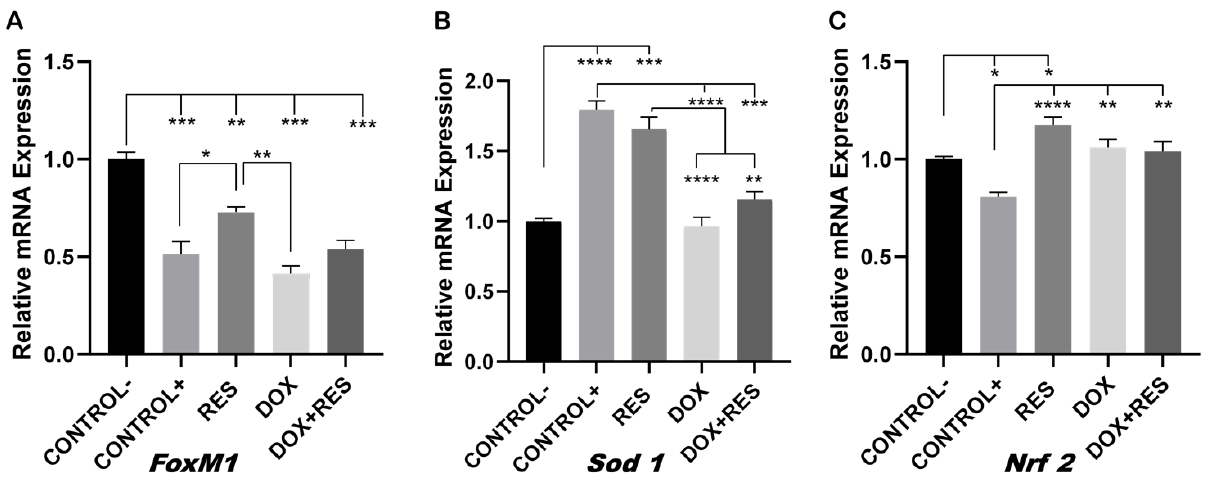
Figure 4. Involvement of FoxM1 on osteoclast differentiation and oxidative stress. RAW 264.7 cells were cultured for 4 days with M-CSF (30 ng/mL) and RANKL (50 ng/mL) and treated with resveratrol (RES), MitoTEMPO (MT) and doxorubicin (DOX) alone or together. RNA from the cells was obtained, and expression levels for FoxM1 ( A ), Sod 1 ( B ) and Nrf 2 ( C ) were analyzed by qPCR. One- way ANOVA, Tukey’s multiple comparisons test, *— p ≤ 0.05, **— p ≤ 0.01, ***— p ≤ 0.001, ****— p ≤ 0.0001.